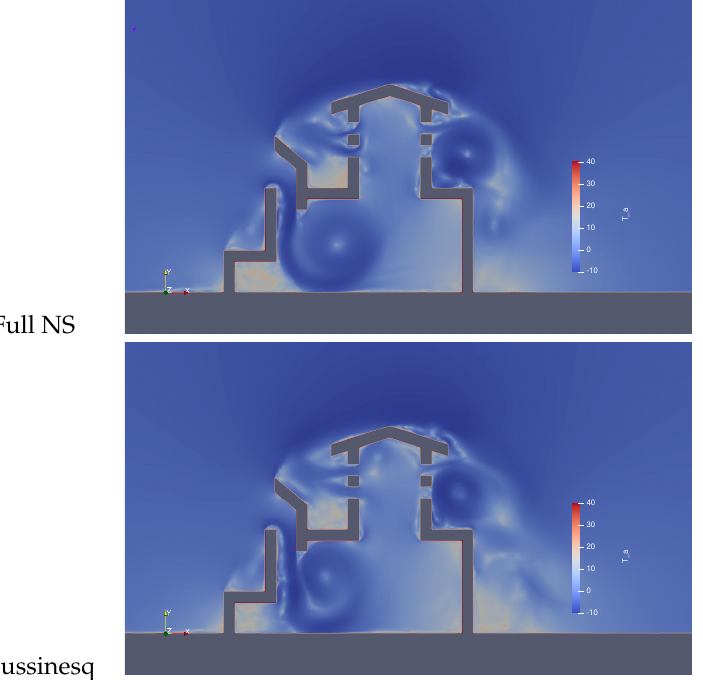
Figure 19. Wind tower 1. Apparent temperature field obtained by the full NS and the Boussinesq model with U ∞ = 5